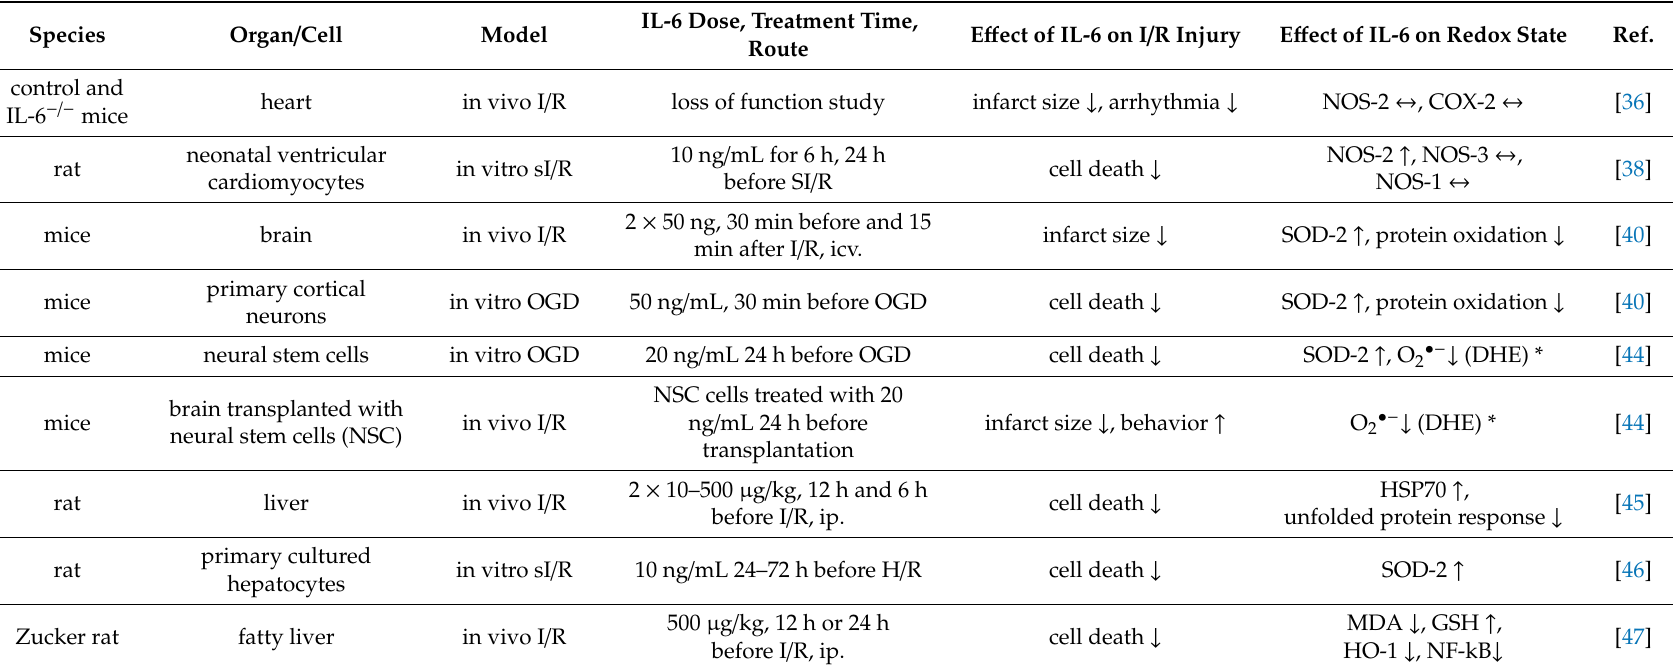
Table 2. E ff ect of interleukin-6 (IL-6) on redox state in settings of ischemia / reperfusion injury (I /